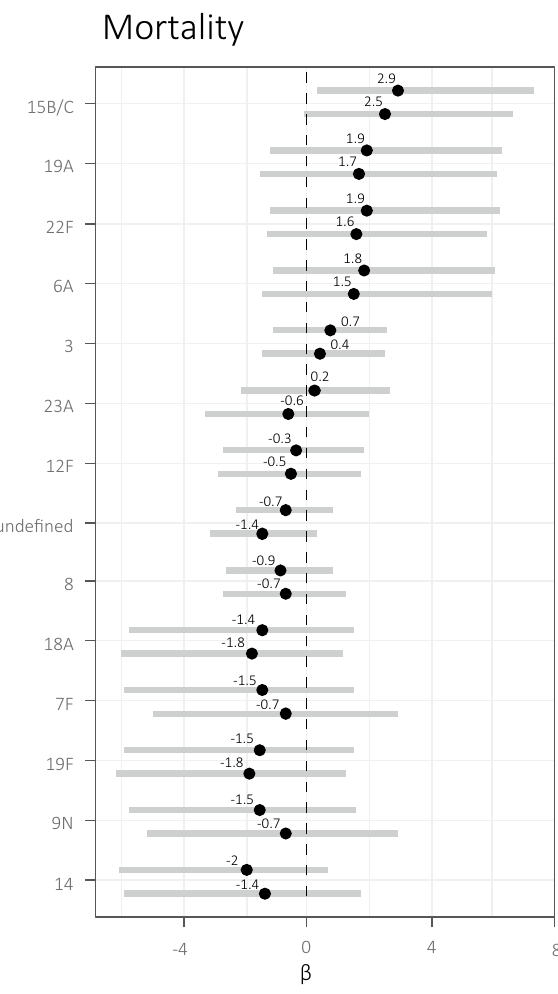
Figure 2. Serotypes associated with higher case fatality risk (South African meningitis patients, 2018–2019). The 90% highest density intervals (HDI) of the posterior distributions of the estimated regression coefficients (β) are depicted as horizontal bars and dots indicate their medians, for both unadjusted (upper bars) and adjusted (lower bars; covariables HIV status and patient age) full Bayesian multinomial logit models. Serotypes are sorted from top to bottom in decreasing risk of case fatality as compared to the case fatality rate of the ad-hoc reference serotype 10A, for which β was set to 0. n = 57. This figure was generated using R (R Core Team (2019)). R: A language and environment for statistical computing. R Foundation for Statistical Computing, Vienna, Austria. https:// www.R- proje ct.